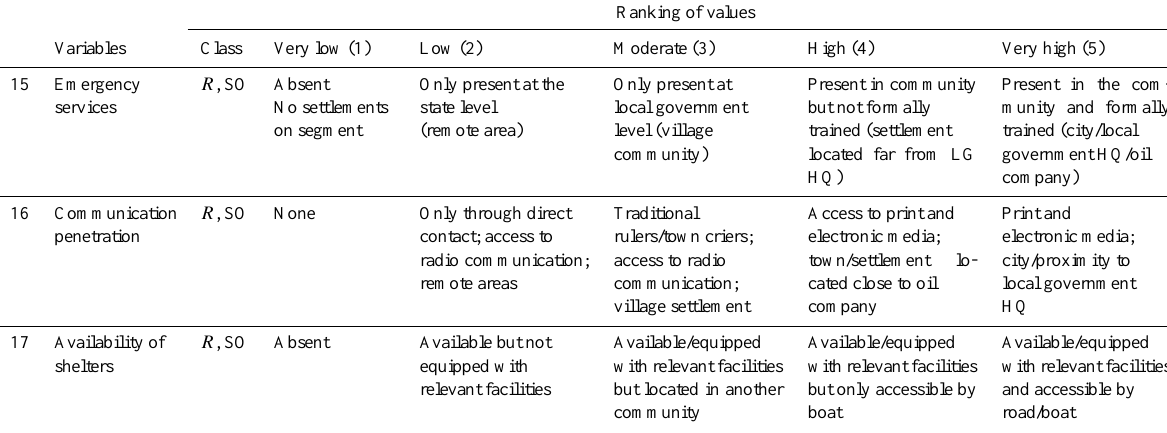
Table 4. Data range and ranking of the resilience CV SLR I